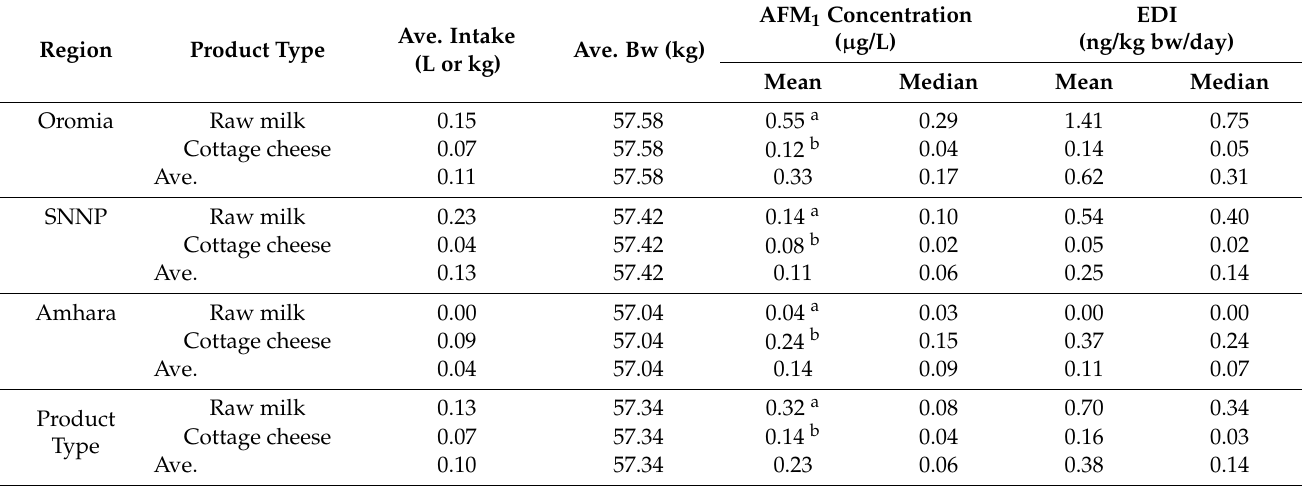
Table 2. Exposure estimation of AFM 1 in adult populations in three regions of